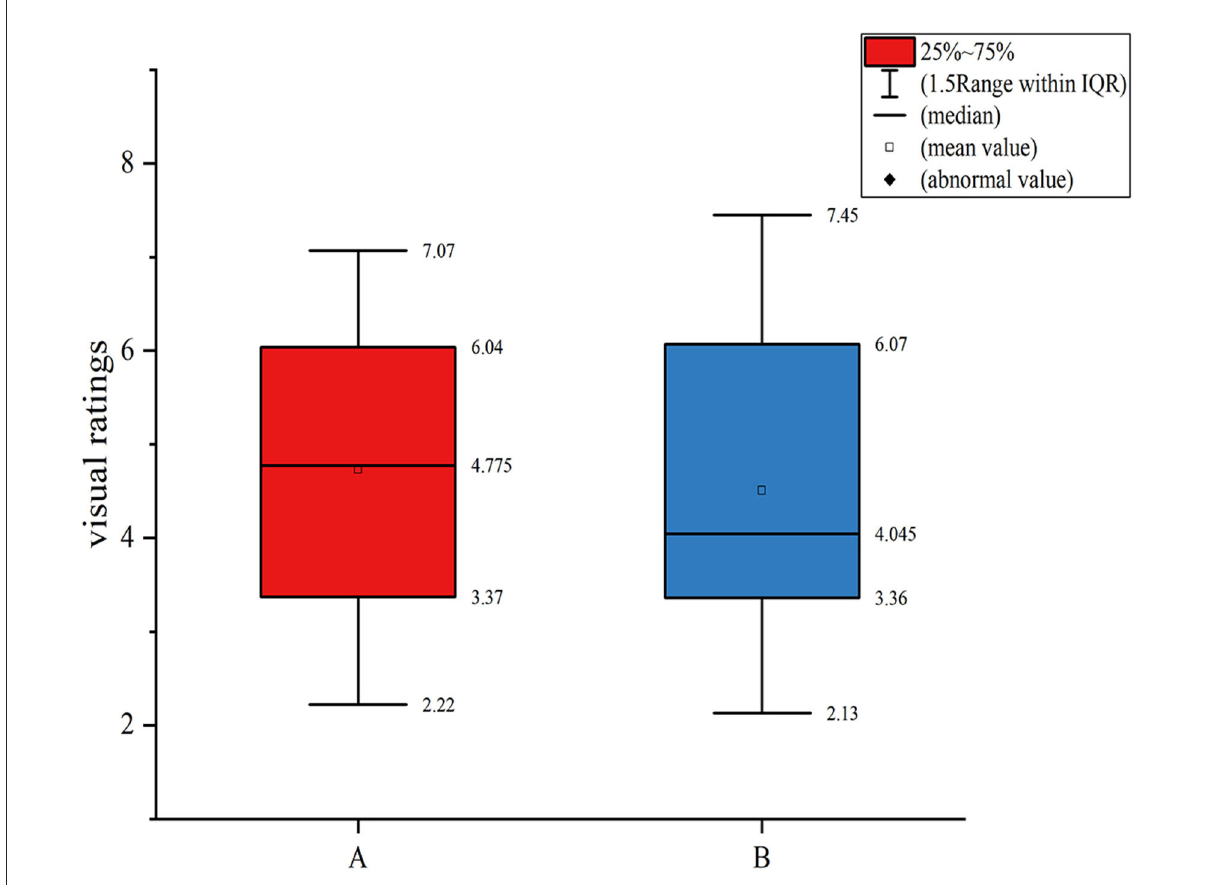
FIGURE6 Boxplot of 30 subjects’ visual